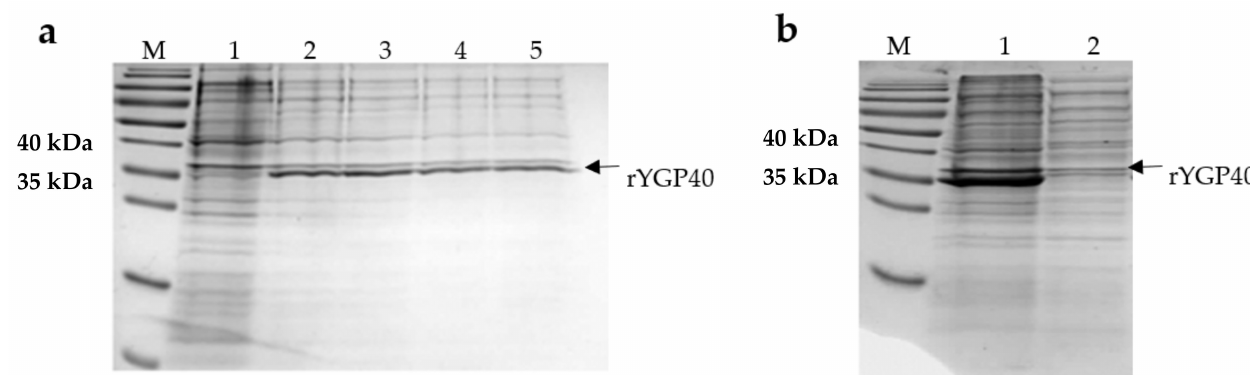
Figure 1. ( a ) rYGP40 expression analysis by SDS-PAGE. 1: sample taken before the expression induction with IPTG, lanes 2–5: samples taken after 1–4 h after expression induction. ( b ) rYGP40 solubility analysis; 1—pellet/insoluble fraction; 2—supernatant/soluble fraction. M: protein weight marker PageRuler Prestained Protein